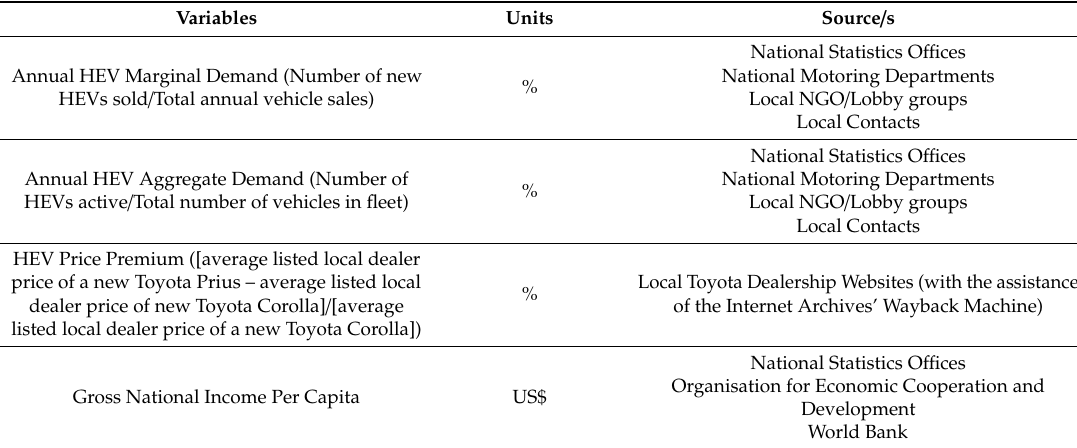
Table 1. List of data variables collected for each region, including units and data